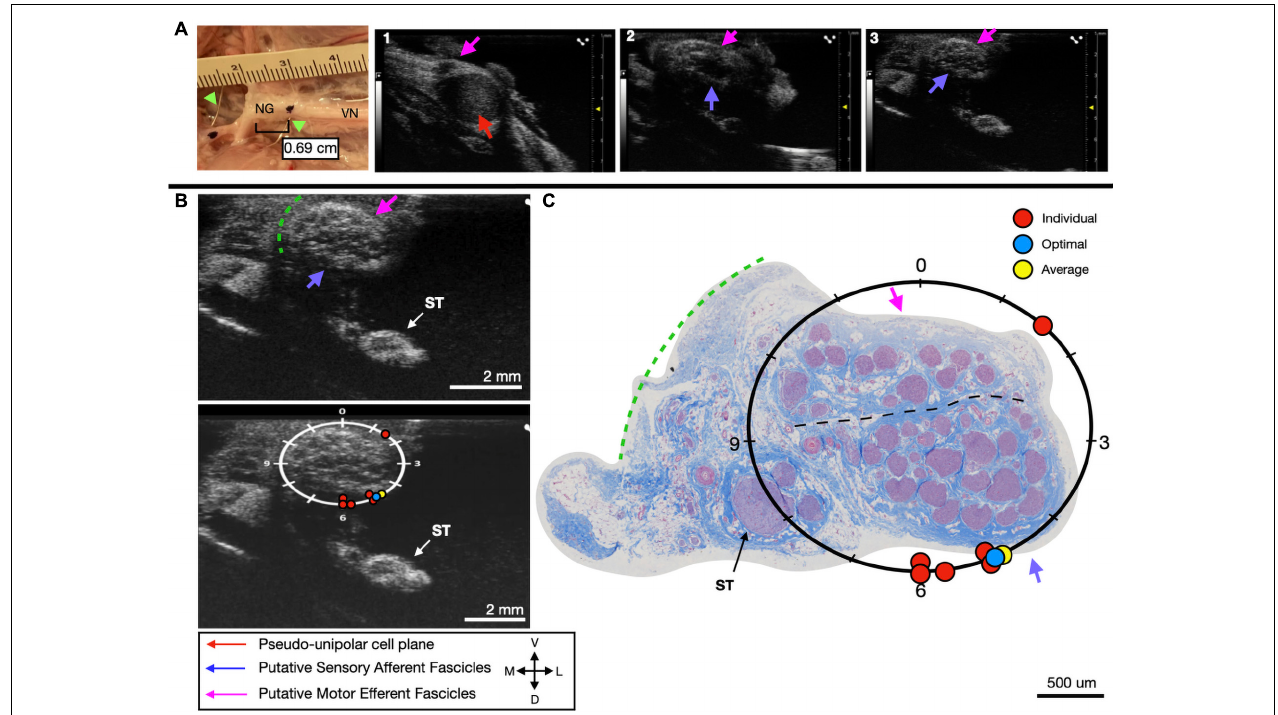
FIGURE 6 | Subject 2 (A) From Left to Right: Location of wire fiducials and histology dye within the surgical pocket. The location of the paired ultrasound video and required placement of stimulating contact is at wire fiducial two [0.69 cm from the superior laryngeal coming off of the nodose ganglion (NG)]. (A1–3) Progressive ultrasound images in the cranial to caudal direction from the NG to the cervical vagus nerve (VN), and location where volunteers were requested to place the stimulating contact (1–3, respectively). Red arrow indicates pseudo-unipolar cell region of the NG, pink arrows indicate motor efferent region, purple arrow indicates sensory afferent region, as confirmed via histology. (B) Ultrasound cross sections of wire fiducial two, where volunteers were asked to trace the sensory afferent axons from the NG. Top panel: pink arrows note motor efferent region, purple arrow indicates the sensory afferent fascicle grouping, green dashed line indicates area of transected connective tissue during removal for histology. Bottom panel: analog clock face placed on test video to give volunteers locations to place the hypothetical stimulating contact based on their tracing task, green dashed line indicates area of transected connective tissue during removal for histology. (C) Histology slice from wire fiducial two, as indicated with histology dye, with analog clock face to demonstrate stimulating contact locations as placed by volunteers in the ultrasound video. Green dashed line indicates area of transected connective tissue during removal for histology. (B,C) Red circles indicate each volunteer’s placement of the stimulating contact, the yellow circle indicates the average response, and the blue circle indicates the optimal contact location. Sympathetic trunk (ST), medial (M), ventral (V), lateral (L), dorsal